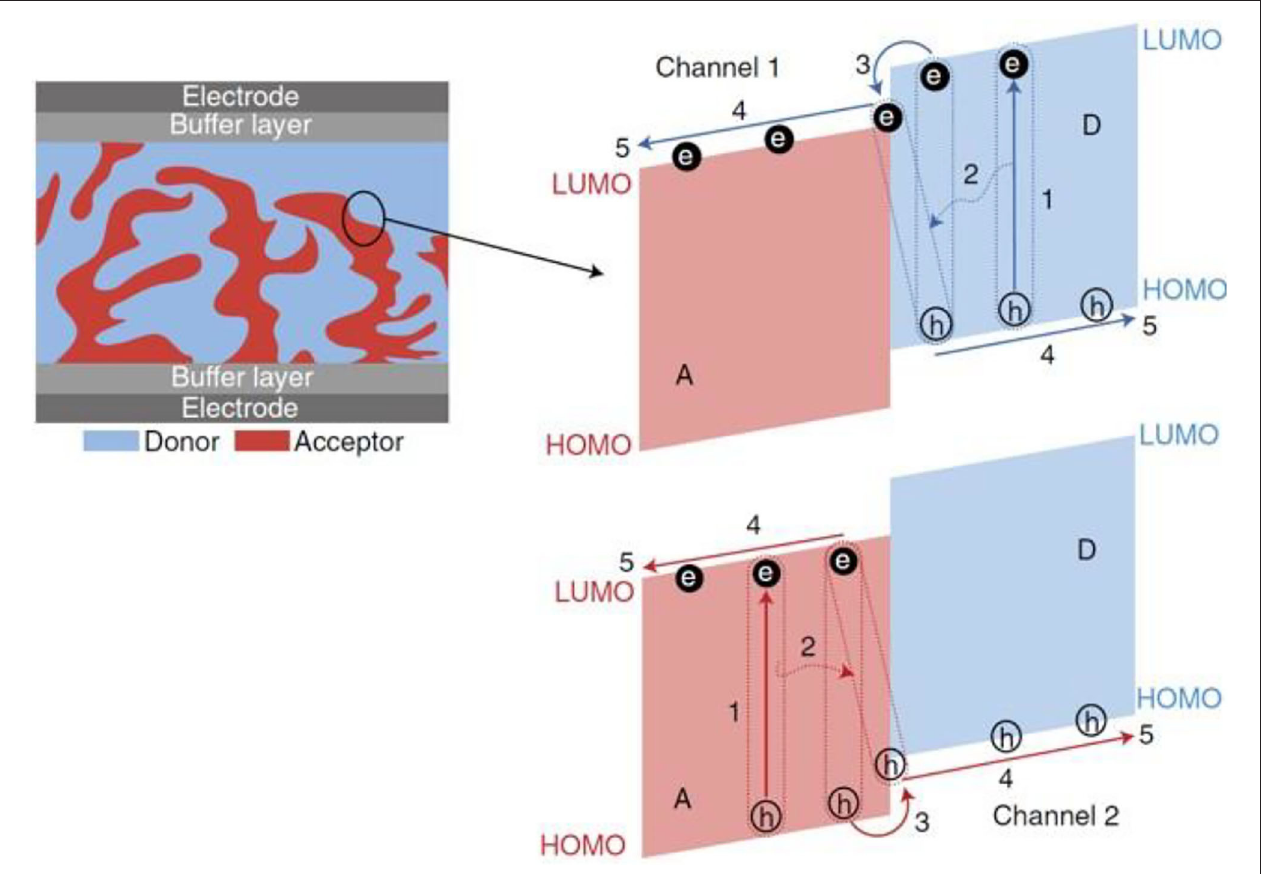
FIGURE 1 | The operating mechanism of OPVs: (1) absorption of photons and creation of excitons; (2) diffusion of excitons to D/A interfaces; (3) dissociation of excitons to free charge carriers (holes and electrons) at D/A interfaces; (4) transportation of the charge carriers to electrodes; (5) extraction of the charge carriers at the electrodes. Copyright 2018, Macmillan Publishers Limited, part of Springer